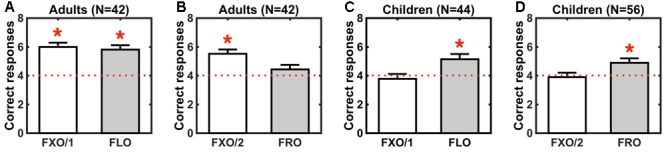
String recognition performance (average correct trials) in adults exposed to a fixed order grammar (FXO/1) or a flexible order grammar (FLO) in Experiment 1 (A) and to a fixed order grammar (FXO/2) or a free order grammar (FRO) in Experiment 2 (B), and in children exposed to the same grammars in Experiments 3 (C) and 4 (D). Different colors of bars (white or gray) correspond to different groups of participants, exposed to different grammars. Error bars denote standard errors of the mean. Red dotted lines show chance level (4 correct trials out of 8). Red asterisks indicate statistically significant effects relative to chance (Table 3).